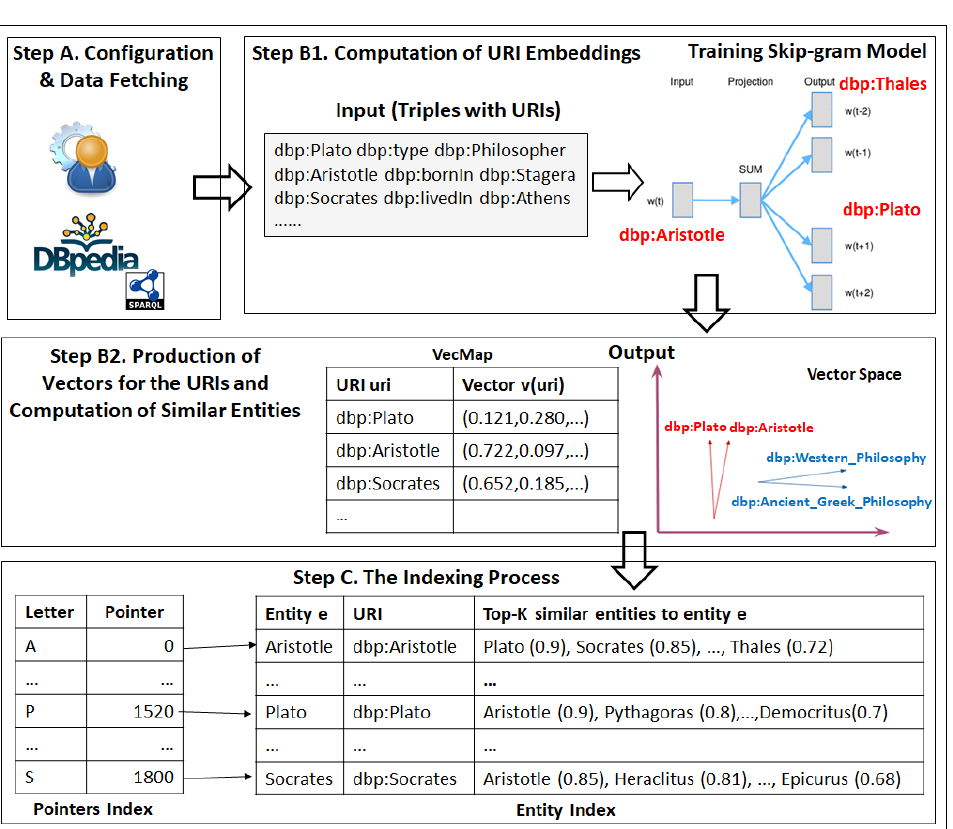
Figure 4. The process of Finding and Storing the Top-K similar entities through embeddings in specialized